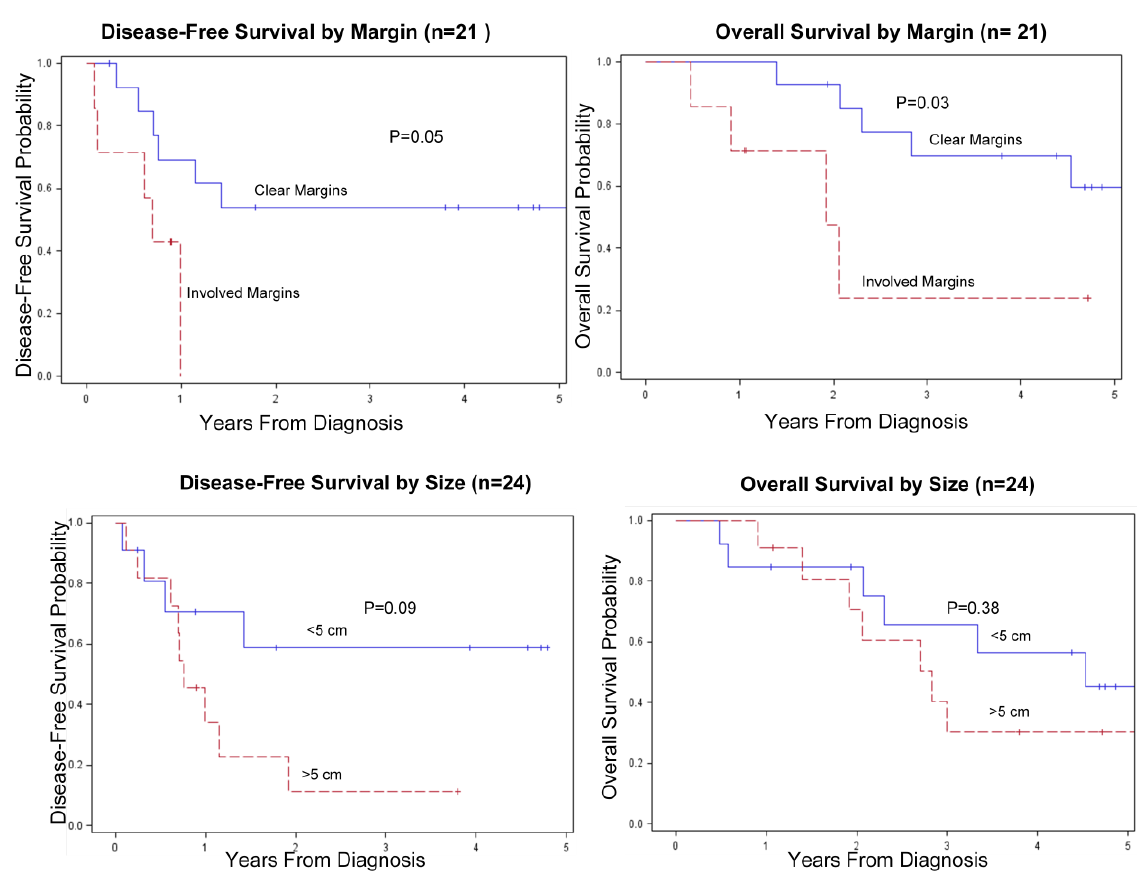
Figure 1. ( a ) DFS and OS according to margin status. ( b ) DFS and OS according to size in Soft Tissue Sarcoma